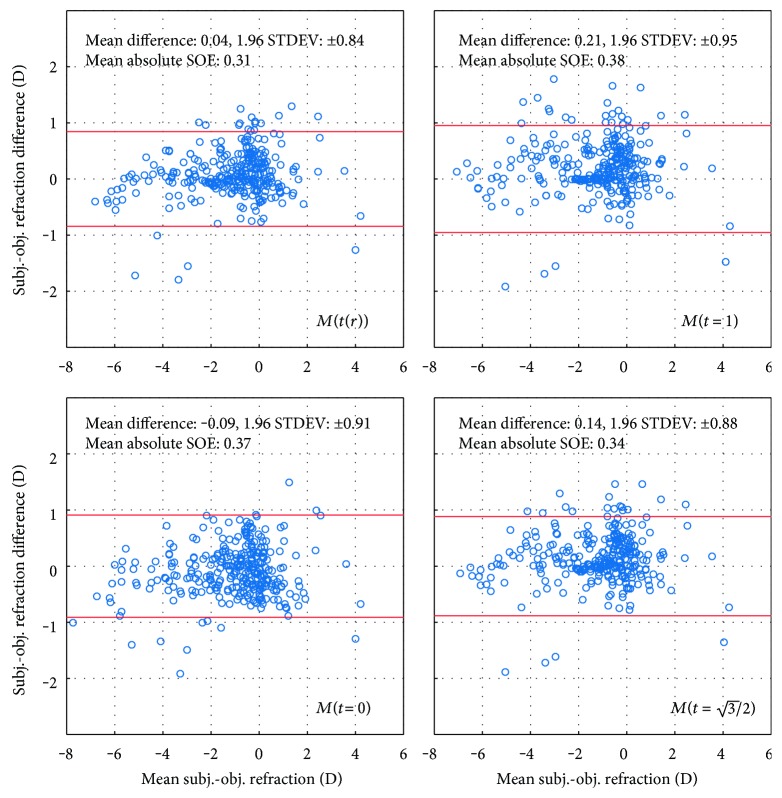
Bland-Altman plots [39] illustrating the accuracy of the prediction of subjective refraction in the AHM dataset for different values of parameter t. The data was obtained from WFE without any rescaling of the pupil radii to a common value.